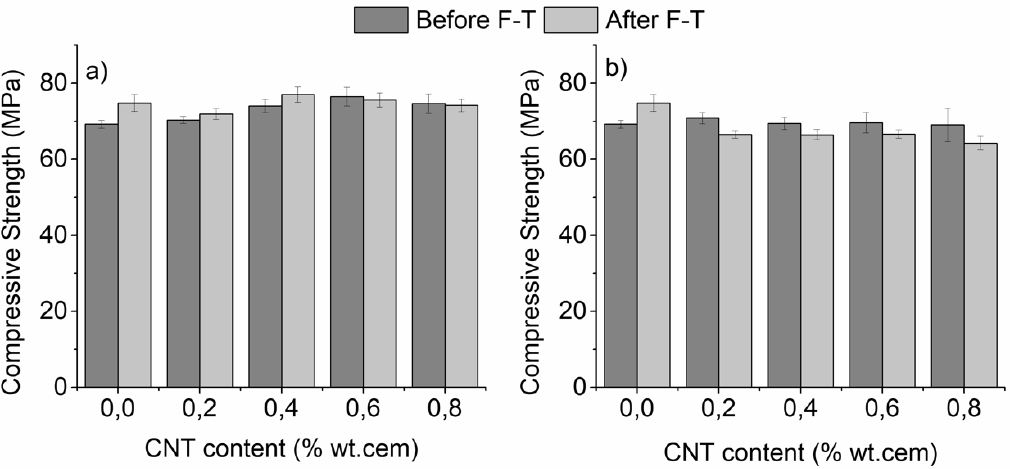
Figure 4. Compressive strength of nano-mortars prepared with ( a ) superplasticizer and ( b ) surfactant as dispersive agent, as a function of F-T exposure (plain specimens have been added for reference).